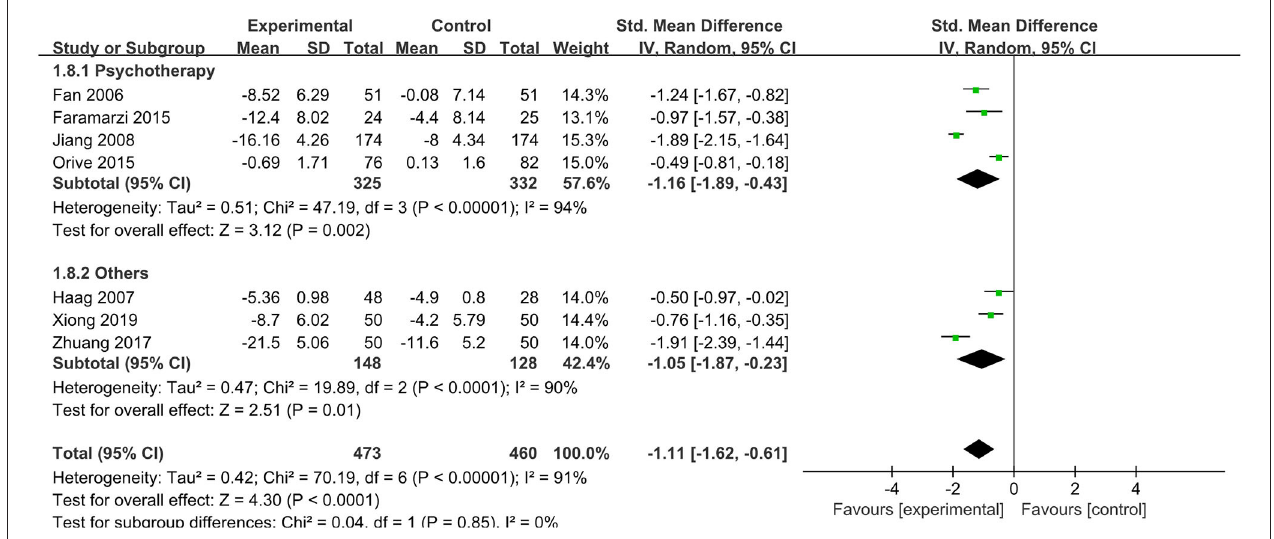
FIGURE 7 | Meta-analysis of the effect of psychological interventions on depression. CI, confidence interval; Others, relaxation or cognitive behavioral therapy/cognitive behavioral therapy/relaxation